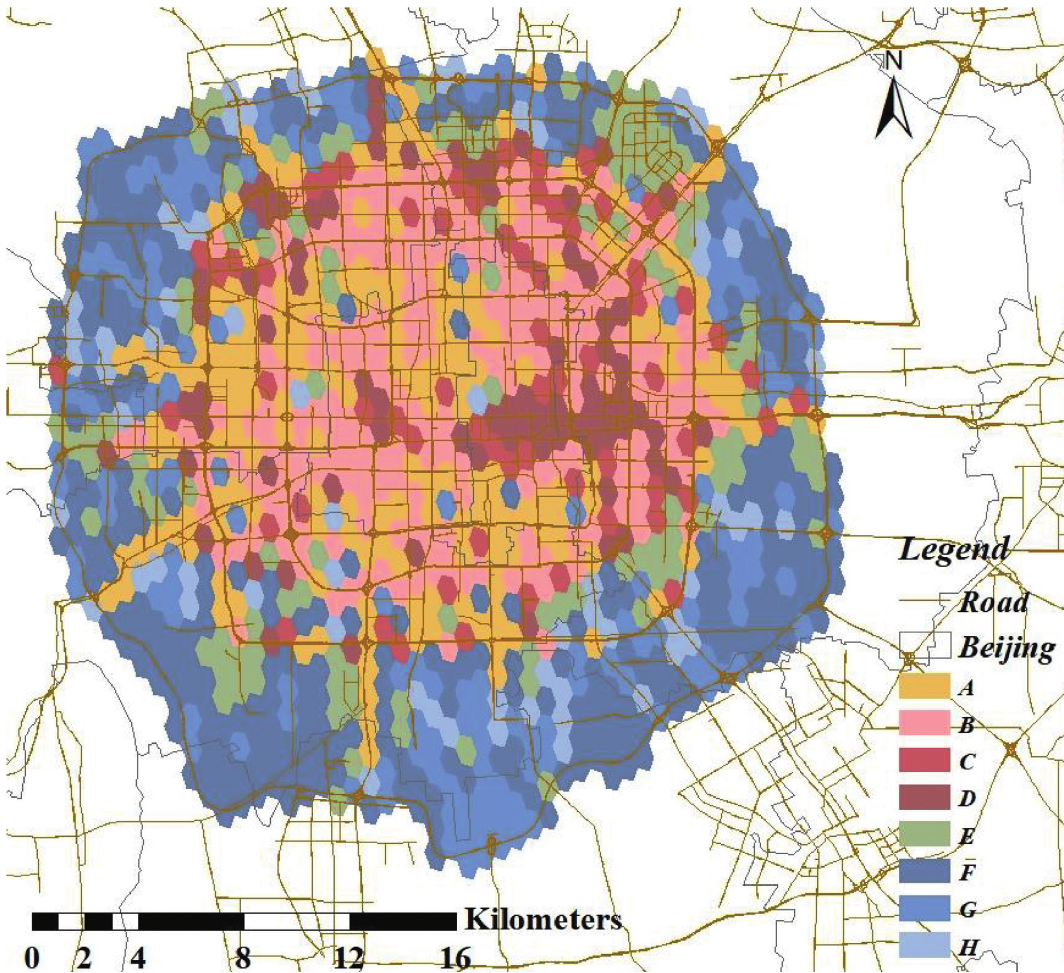
Figure 12: Balance between accessibility and